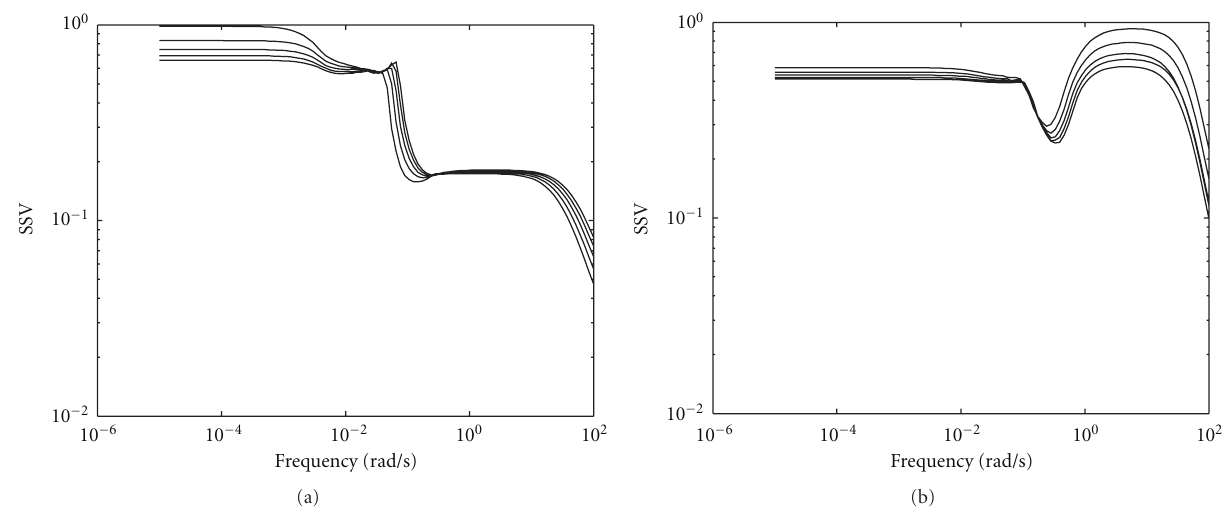
Figure 3: Structured singular value for parametric uncertainties and glucose levels (40, 60, 80, 100, and 120)mg/dL for (a) LPV, (b) UC.